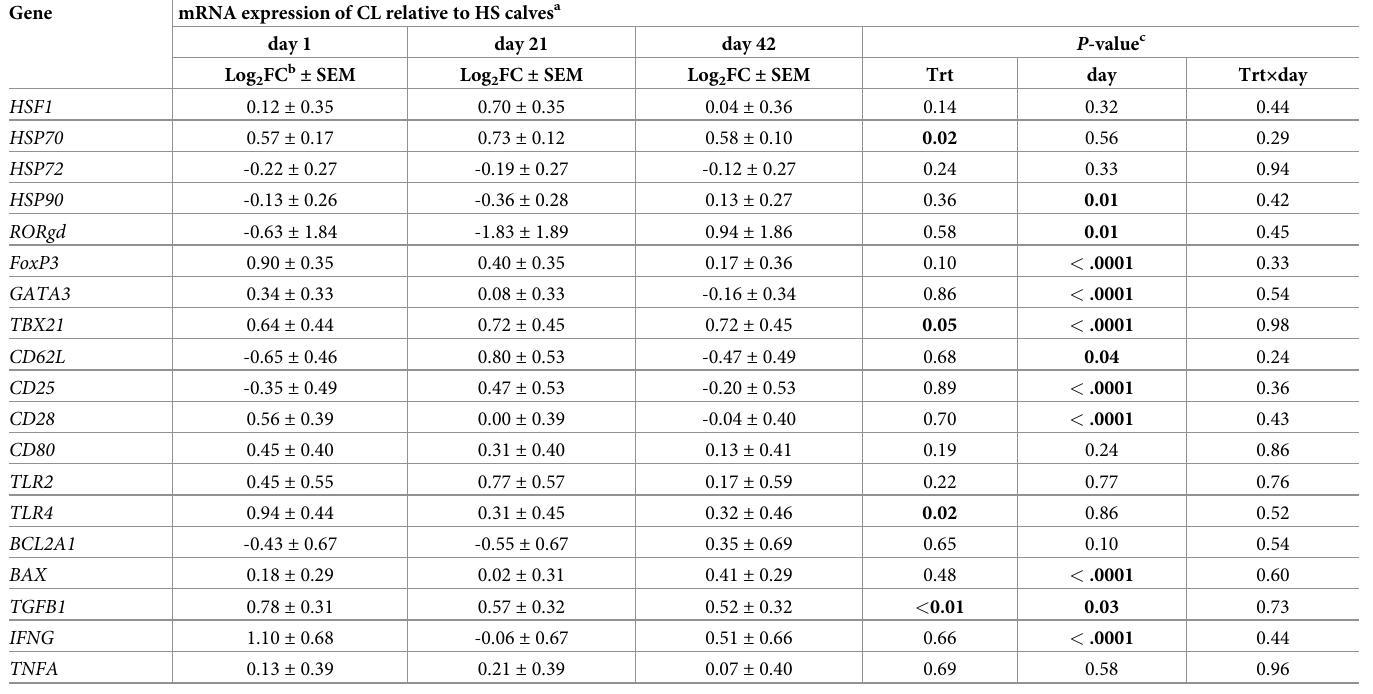
Peripheral blood leukocyte heat stress-related gene expression was assessed on d 1, 21, and 42. Calves provided heat stress abatement had greater HSP70 mRNA expression when compared to HS calves ( P = 0.02; Table 2). There was also a day effect for HSP90 mRNA expression ( P = 0.01) which was greater at d 0 compared to d 42 in both treatments ( P = 0.01; Table 2). Table 2. mRNA expression of peripheral blood leukocytes isolated from dairy calves at 1, 21 and 42 days of age. Gene mRNA expression of CL relative to HS calves